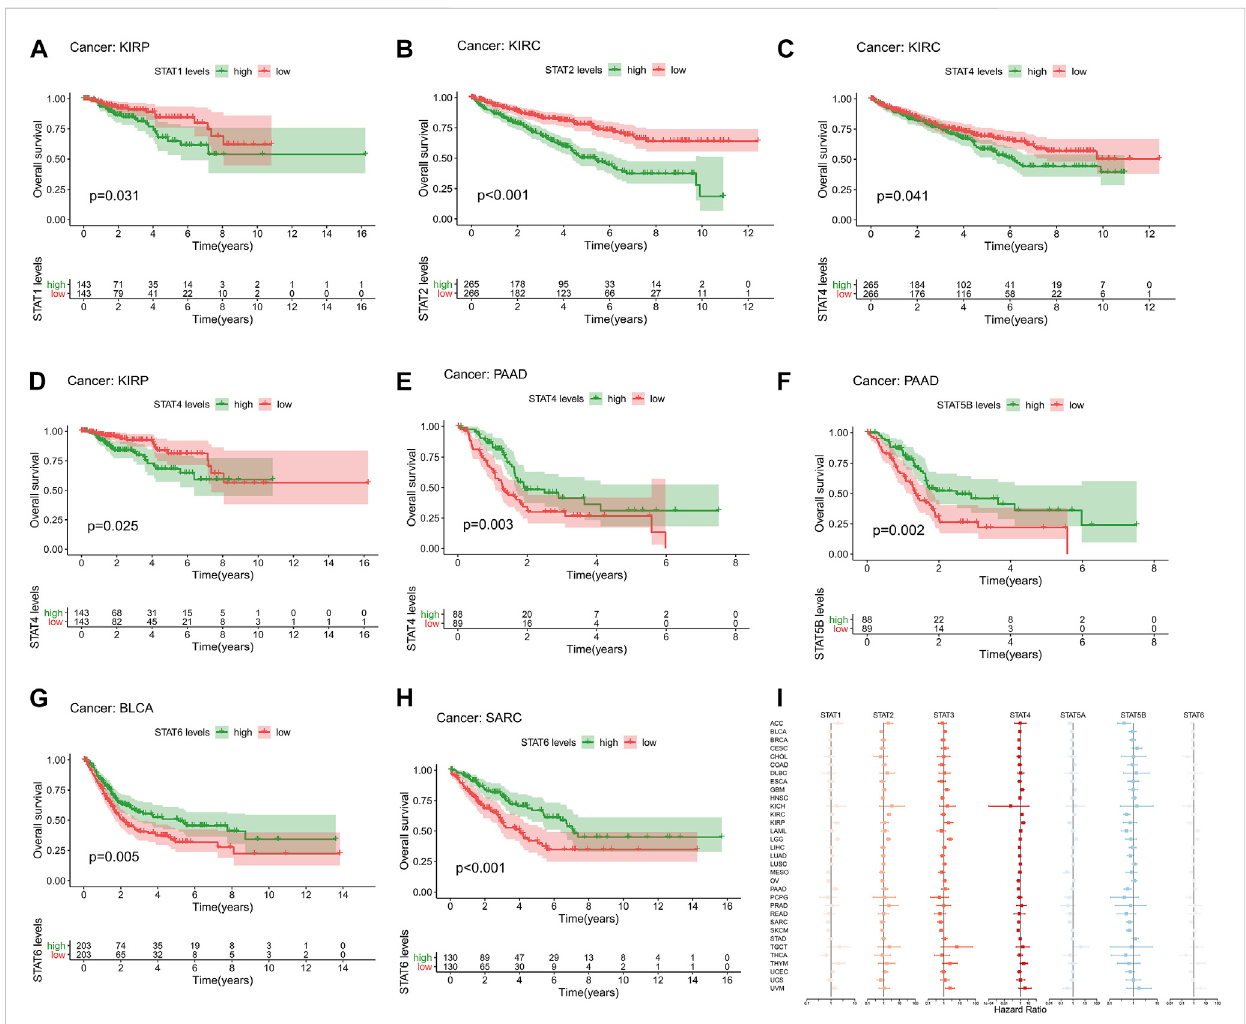
FIGURE 3 Survival analysis of STATs in pan-cancer. (A) Kaplan-Meier plot showed that low STAT1 expression indicated a better prognosis in KIRP patients ( p = 0.031). (B) Kaplan-MeierplotrevealedthatlowSTAT2expressionsuggestedamorefavorableprognosisinKIRCpatients( p < 0.001). (C) Kaplan-Meierplot visualizedthathighexpressionlevelsofSTAT4wereassociatedwithworseclinicaloutcomesinKIRCpatients( p =0.041). (D) Kaplan-Meierplotdisplayed thatelevatedSTAT4levelswerelinkedwithmoreunfavorableclinicaloutcomesinKIRPpatients( p =0.025). (E) Kaplan-Meierplotportrayedthatup- regulated STAT4 expression was correlated with better prognosis in PAAD patients ( p = 0.003). (F) Kaplan-Meier plot exhibited that high STAT5B levels indicatedabetteroverallsurvivalstatusinpatientswithPAAD( p =0.002). (G) Kaplan-Meierplotillustratedthatdown-regulationofSTAT6expressionwas associated with worse clinical outcomes in patients with BLCA ( p = 0.005). (H) Kaplan-Meier plot characterizing that low STAT6 levels suggested a more unfavorable prognosis in patients with SARC ( p < 0.001). (I) Forest plot showing the results of Cox proportional hazards regression analyses of STATs